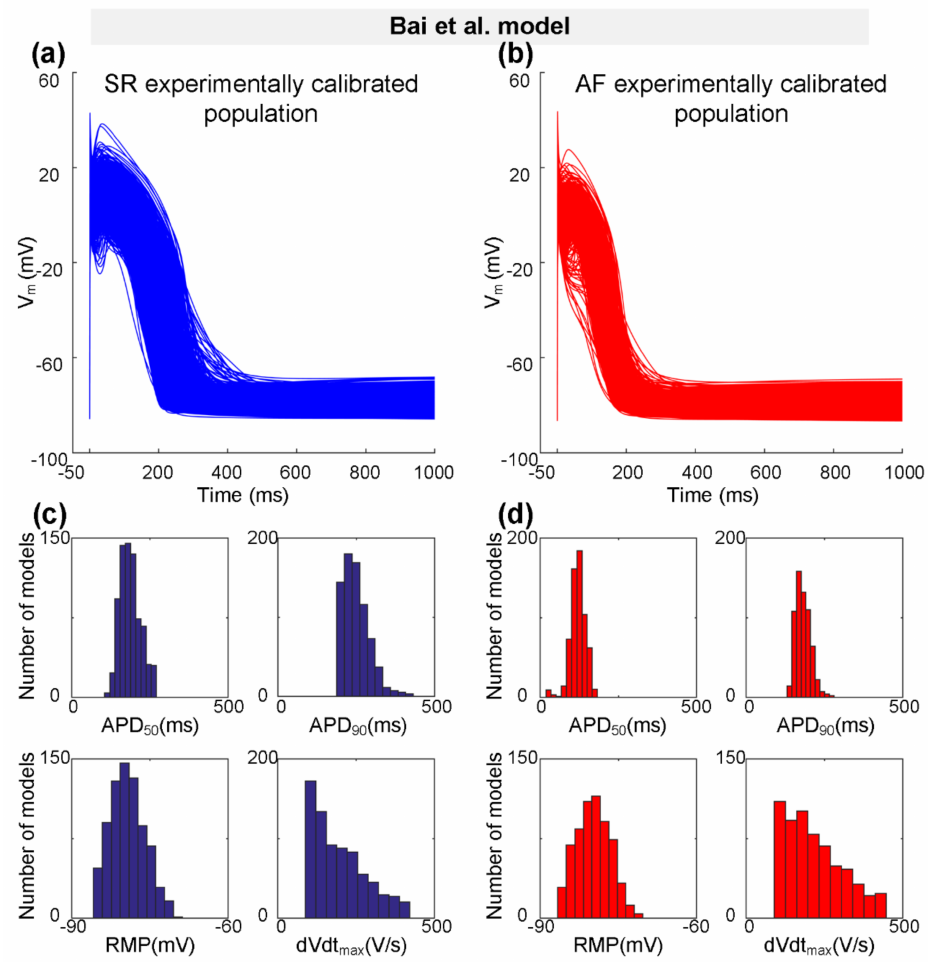
Figure 2. The experimentally calibrated populations constructed with the Bai et al. model for sinus rhythm (SR, blue) and atrial fibrillation (AF, red) conditions. ( a , b ) Representative traces of action potential (AP) models in SR and Pitx2 -induced AF conditions. ( c , d ) Distributions of AP biomarkers (including dVdt max , RMP, APD 50 , and APD 90 ) under SR and Pitx2 -induced AF